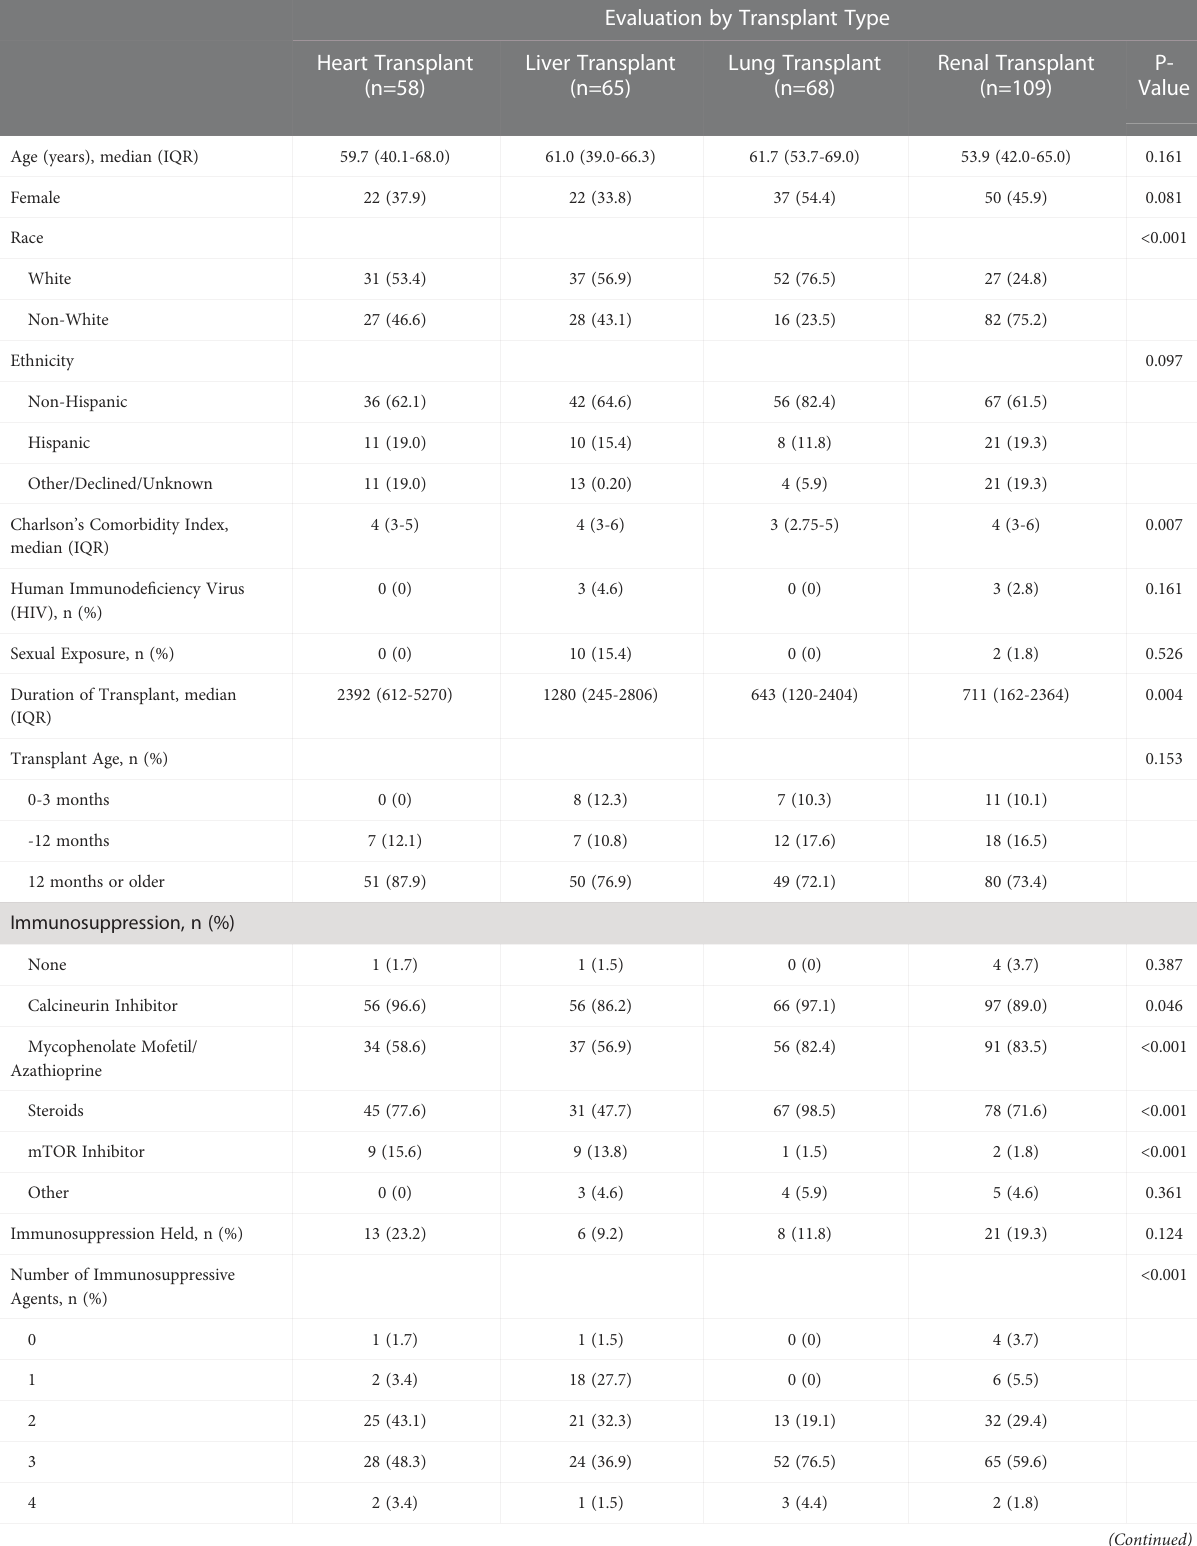
TABLE 1 Baseline Characteristics by Transplant